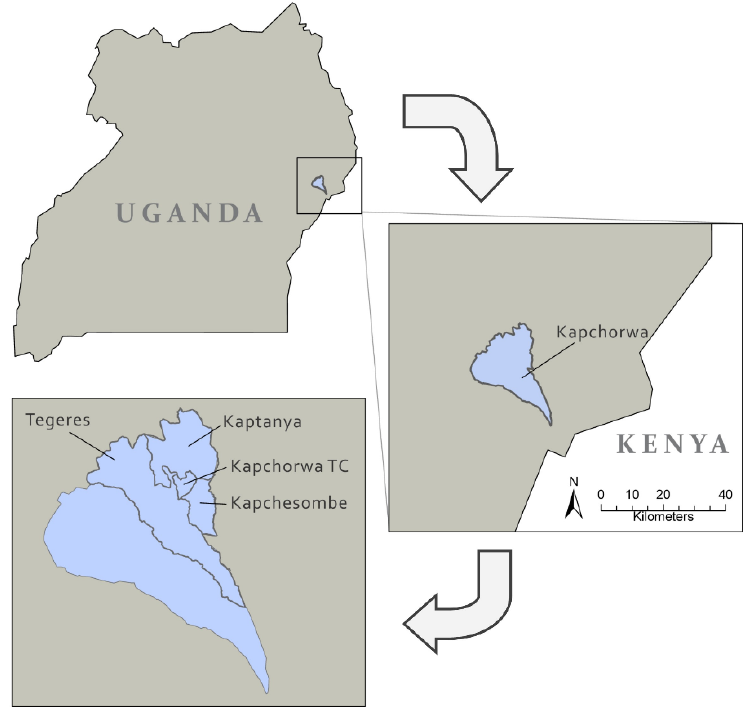
Figure 1. Location of the Kapchorwa District. Published under a CC BY license, with permission from Björn Weeser, original copyright 2019.